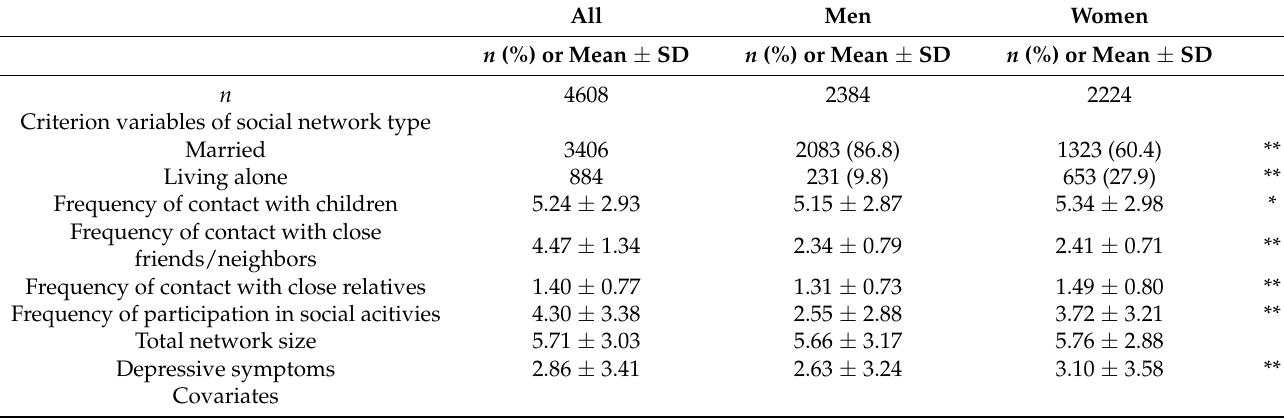
Table 1. Characteristics of the social network criterion, socioeconomic and health -related variables of older men ( n = 2384) and women ( n = 2224) in the 2017 Korean Living Profile Survey of Older